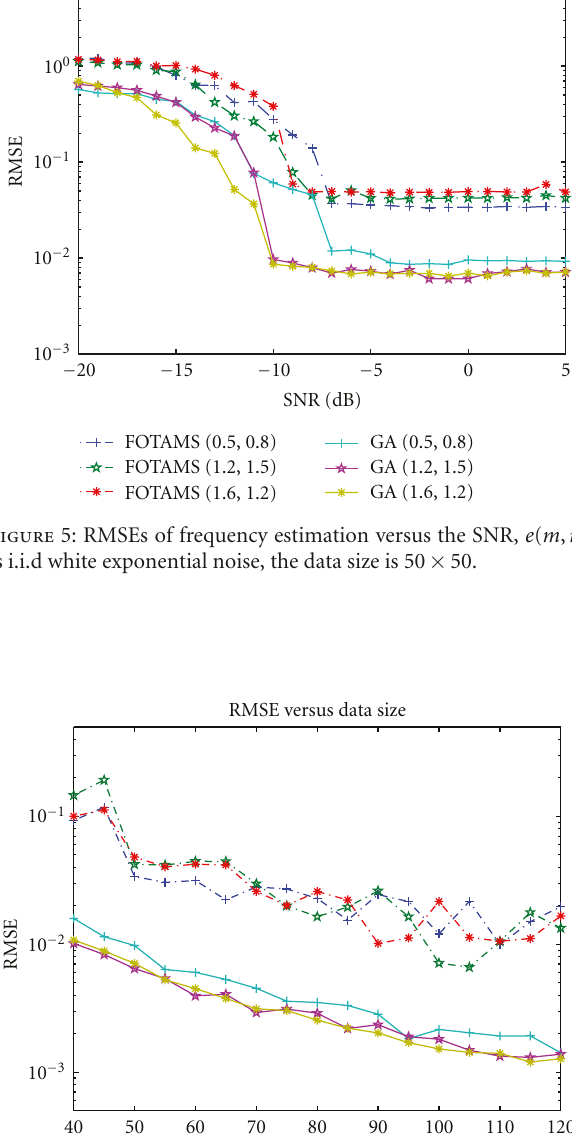
The GA parameters are set as follows. Initial population M = 300, memorial population N = 120, genetic times T = 300, crossover probability P c = 0 . 6, mutation probability . 05, mutation control parameter b = 1, niche P m = 0 destining distance R = 0 . 1, and individual penalty P = 10 − 4